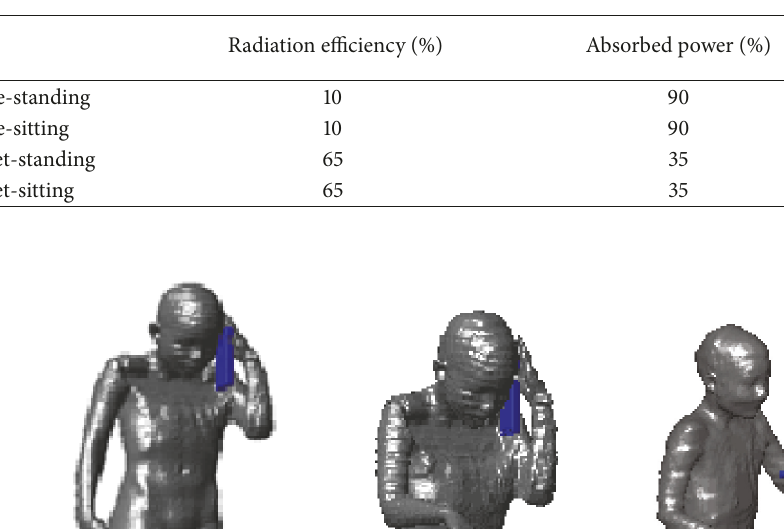
Table 2: The absorbed power and the SAR